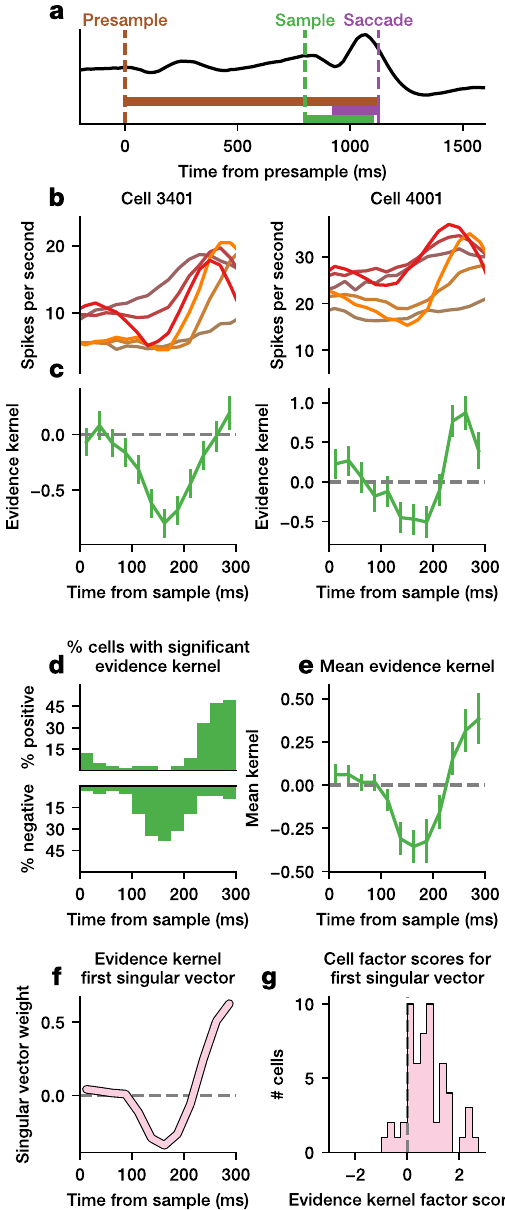
Fig. 4 Evidence dip in individual FEF neurons for Monkey 1. a A schematic of the regression model showing alignment of the kernels to the presample, sample, and saccade. b Smoothed fi ring rate for two example neurons across conditions. Colors are the same as in Figs. 2 – 3. c Evidence kernel for the example neurons in ( b ). Error bars indicate 95% con fi dence interval of the regression coef fi cient. d For each point in time, the number of neurons in the population with signi fi cantly positive (top) or negative (bottom) evidence kernel is shown ( p < 0.05, one-tailed t test). e Mean evidence kernel across neurons. Error bars indicate 95% con fi dence interval of the mean. f The fi rst singular vector of the evidence kernels is shown, along with ( g ) the corresponding factor scores of each neuron. Analyses are based on 57